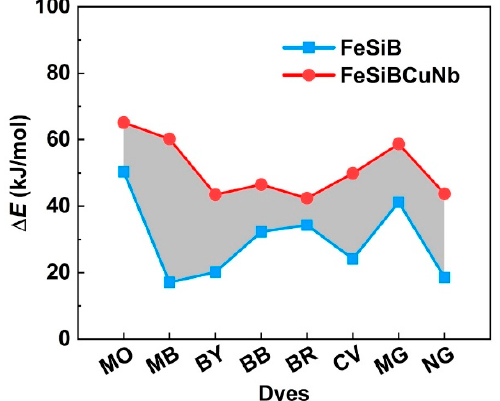
Figure 5. A summary of the activation energy Δ E values of Fe 78 Si 9 B 13 (FeSiB) and Fe 73.5 Si 13.5 B 9 Cu 1 Nb 3 (FeSiBCuNb) metallic glass ribbons for MO, MB, BY, BB, BR, CV, MG and NG dyes. Arrhenius curve fitting is based on reaction temperatures ranging from 25–40 °C.